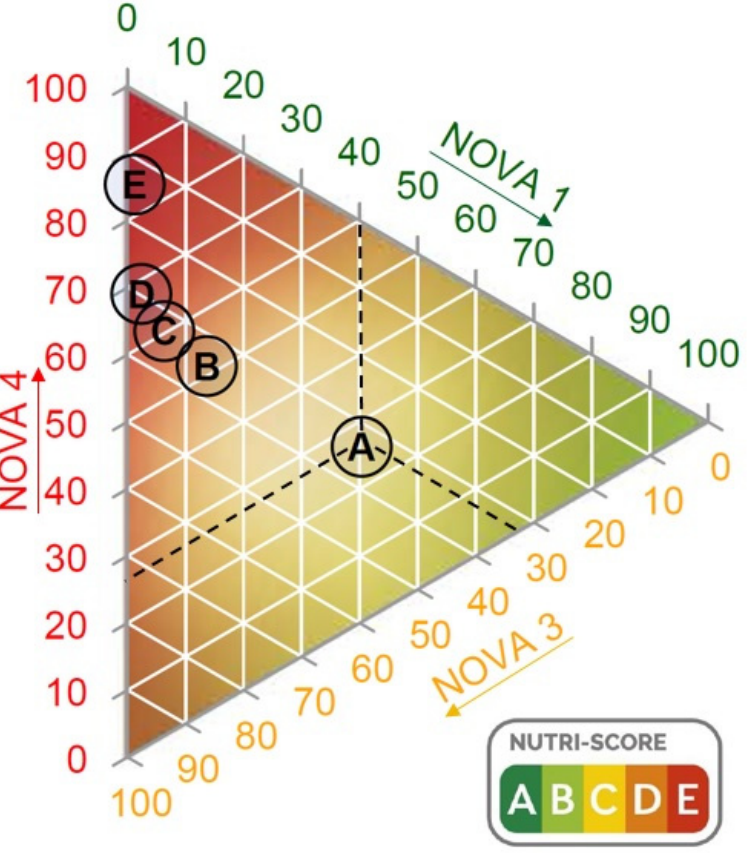
Figure 3. Ternary diagram representing the Nutri-Score categories in accordance with their positions on each of the three axes. Each axis represents the percentage of NOVA groups 1, 3 and 4. NOVA 2 is not shown as it only represented 1% of the data. The dashed lines indicate the coordinates of the different NOVA groups leading to the point where Nutri-Score category A is located (as an example for interpretation).